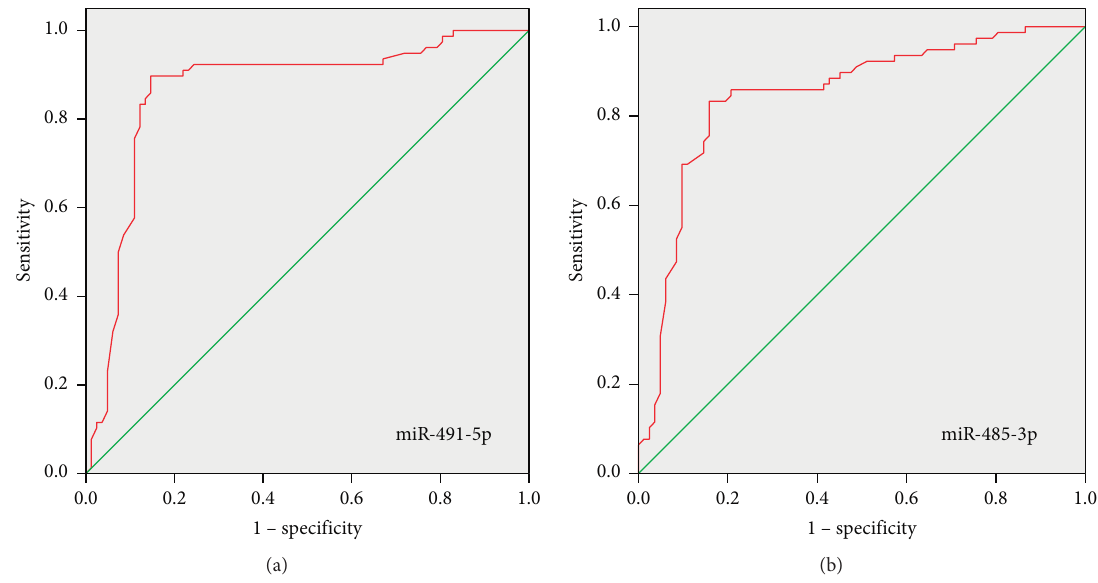
Figure 4: Predictive performance of miR-491-5p and miR-485-3p expressions for the occurrence of vertebral fractures in osteoporotic